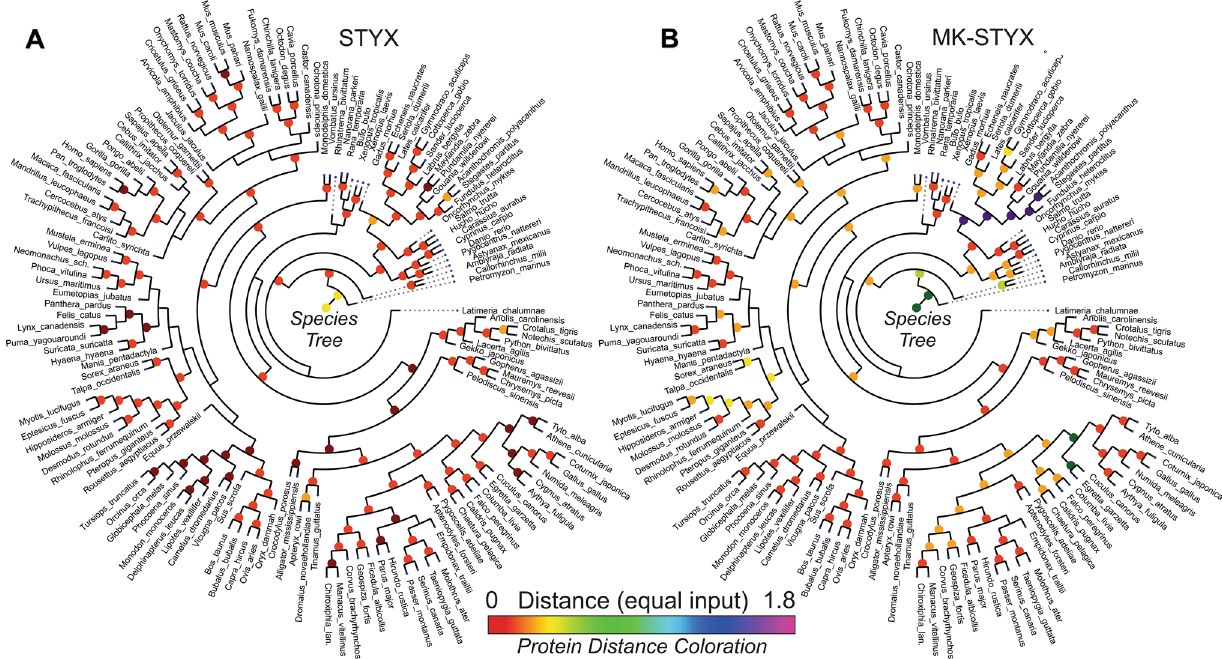
Figure 1. Distance relationships on a phylogenetic tree for STYX and MK-STYX. Phylogenetic tree for 145 of the organisms in our dataset. The tree’s structure is based on standard phylogeny. The tree was constructed using species-species differences (both trees are identical), while the markers plotted over the tree are indicating the protein distances. Nodes are colored on the distance of species-species comparison of the protein sequence (using the equal input model) for STYX ( A ) and MK-STYX ( B ). Cooler colors indicate more divergent sequences and warmer colors indicate more closely related sequences. MK-STYX protein sequence tends to vary greatly when comparing species or clades around the tree. Phylogenetic trees were generated by python (https:// www. python. org.) and phyloT 52 (https:// phylot. bioby te. de/ index. cgi) and analyzed and displayed with iTOL 51 (version 1.0) https:// itol. embl. de/ and environment for tree exploration (ETE3) 56 (http:// eteto olkit.